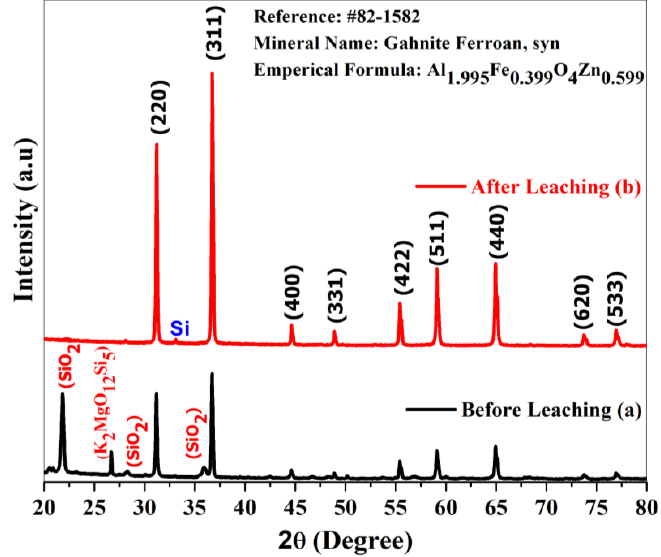
Figure 1. X-ray diffraction pattern of gahnite ferroan composites ( a ) before leaching and ( b ) after leaching obtained powder sample within Bragg ’s diffraction angles of 20° to 80°.